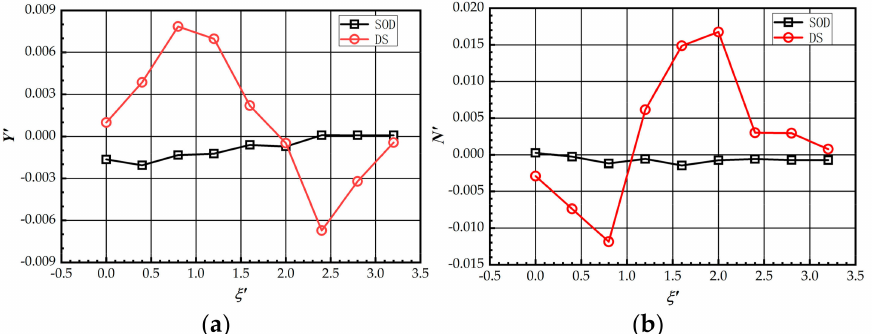
Figure 7. ( a ) The nondimensionalized lateral force Y (cid:48) at different values of ξ (cid:48) for both SOD and DS; ( b ) The nondimensionalized yaw moment N (cid:48) at different values of ξ (cid:48) for both SOD and